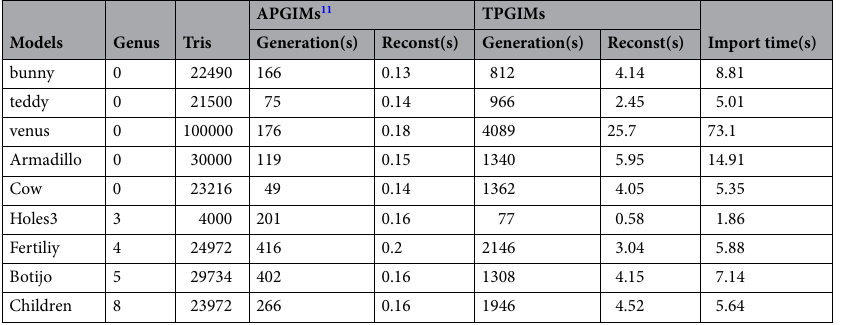
Table 2. Computational efficiency comparison.